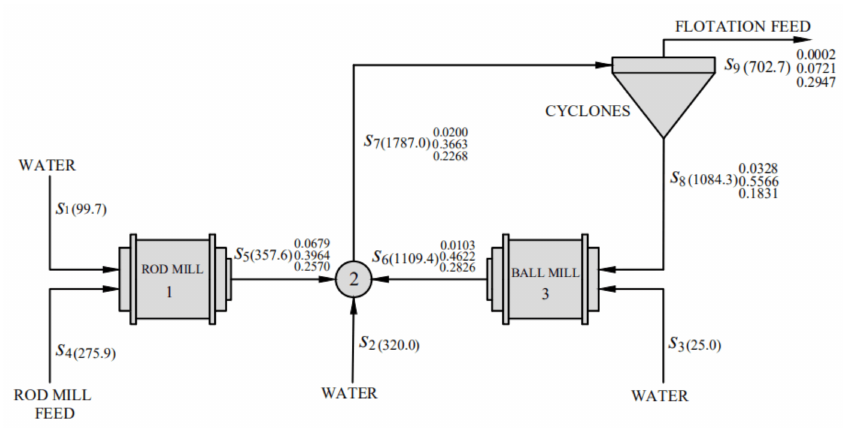
Figure 4. The metallurgical grinding flowsheet with true values of all the measured flowrates and mass weights of three components.